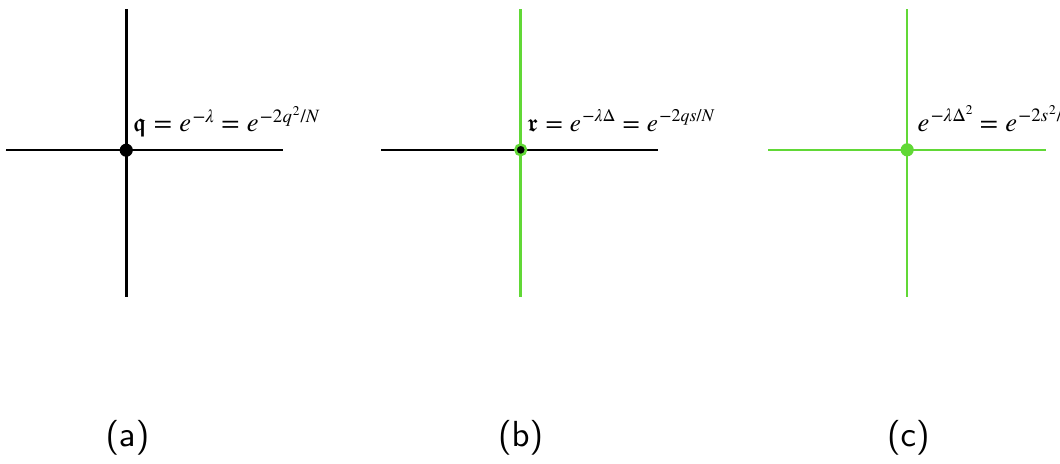
Figure 1 . (a) intersection of two H chords. This gives a factor of q . (b) Intersection of H (black) and M (green) chords. (c) Intersection of two M